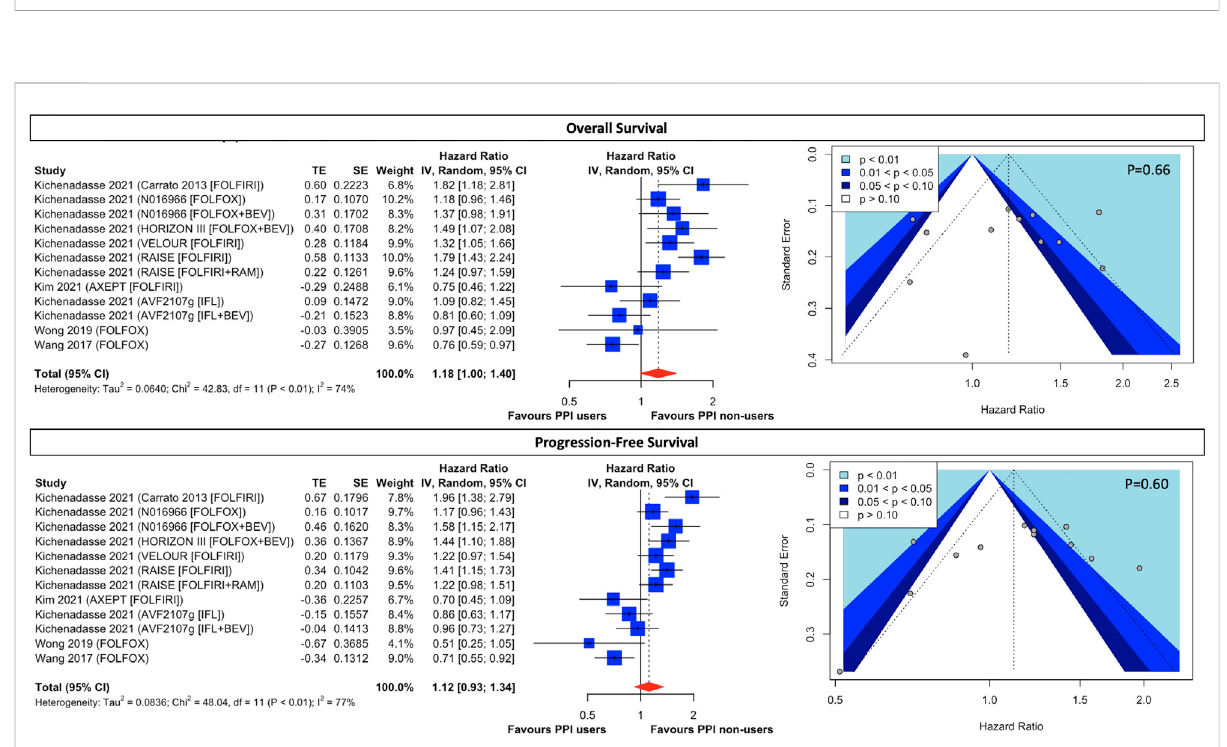
FIGURE 4 Forest plot and funnel plot of comparative overall survival and progression-free survival between PPI users and non-users in CRC cancer patientstreatedwith fl uorouracil-basedregimens.Thesizeofsquaresisproportionaltotheweightofeachstudy.Horizontallinesindicatethe95%CI of each study; diamond, the pooled estimate with 95%. PPI, proton pump inhibitors; CI, con fi dential interval; CRC, colorectal cancers; FOLFOX, folinic acid, fl uorouracil, and oxaliplatin; FOLFIRI, leucovorin, fl uorouracil, and irinotecan; RAM, ramucirumab; IFL, irinotecan, leucovorin, and fl